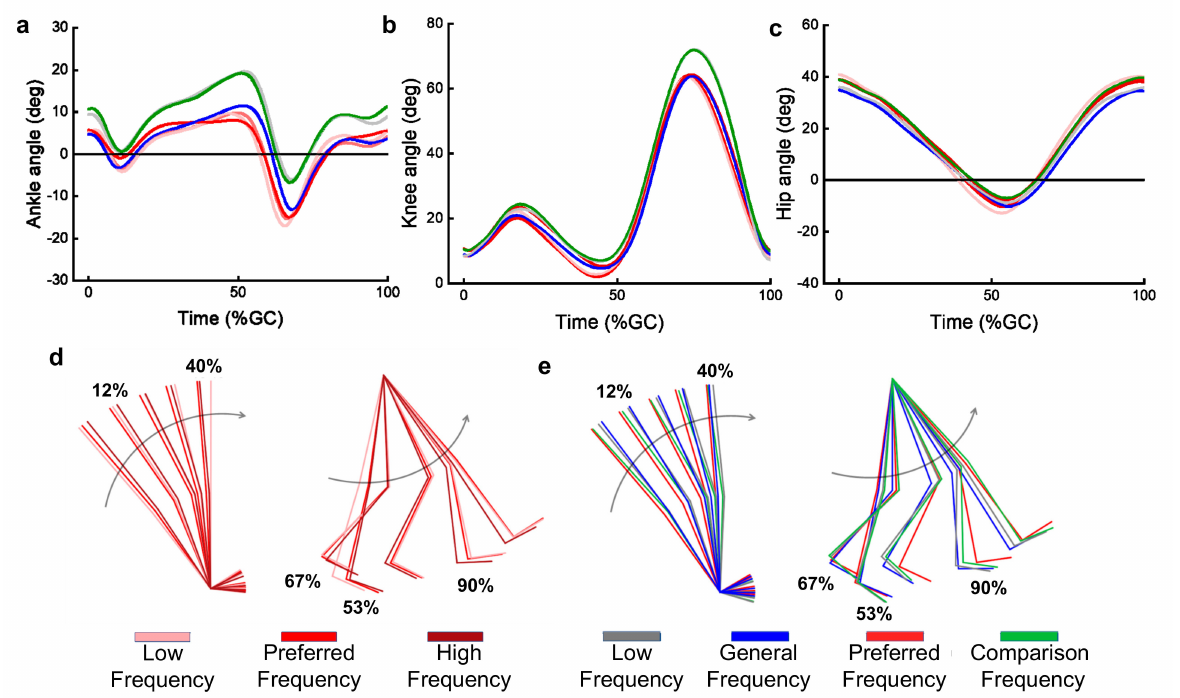
Figure 8. ( a ) Mean ankle angles under different walking conditions; ( b ) mean knee angles under different walking conditions; ( c ) mean hip angles under different walking conditions. ( d ) Stick figures of the mean walking kinematics at different frequencies under preferred speeds. Light red sticks depict walking at lower frequency, red sticks depict walking at preferred frequency and dark red sticks depict walking at higher frequency. Percentages represent different periods of the gait cycle. ( e ) Stick figures of the mean walking kinematics under different conditions. Light grey sticks depict walking under the normal condition, blue sticks depict walking under the general condition, red sticks depict walking under the preferred condition and green sticks depict walking under the comparison condition. Percentages represent different periods of the gait cycle.